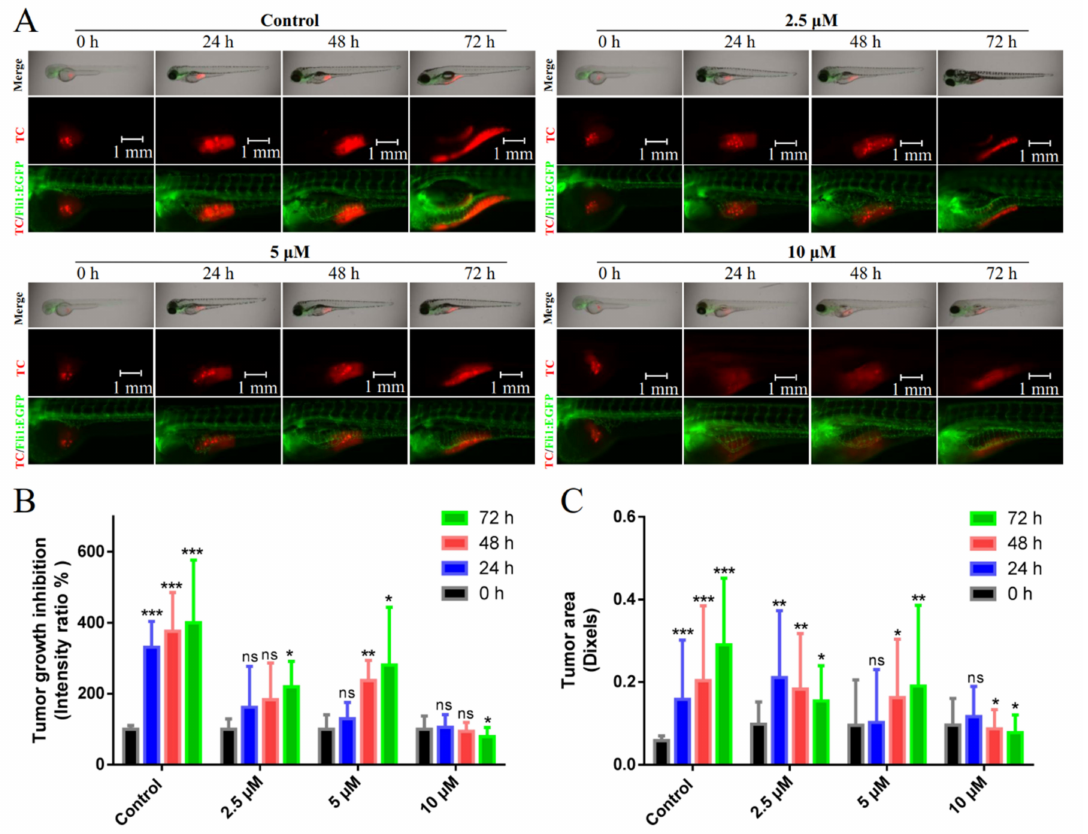
Figure 9. The growth inhibition of MDA-MB-231 cells in zebrafish breast cancer xenografts model inhibited by ∆ − 3 . ( A ) The proliferation of MDA-MB-231 cells (red) in breast cancer zebrafish after treatment with ∆ − 3 (0, 2.5, 5, and 10 µ M) for 72 h. (n = 10/group). The tumor growth inhibition ratio ( B ) and tumor area ( C ) of MDA-MB-231 cells dealt with different concentrations of ∆ − 3 in zebrafish. Data were plotted as means ± SD. Statistical significance was assessed using one-way ANOVA. Values versus the control group: * p < 0.05; ** p < 0.01; *** p < 0.001. ns: not